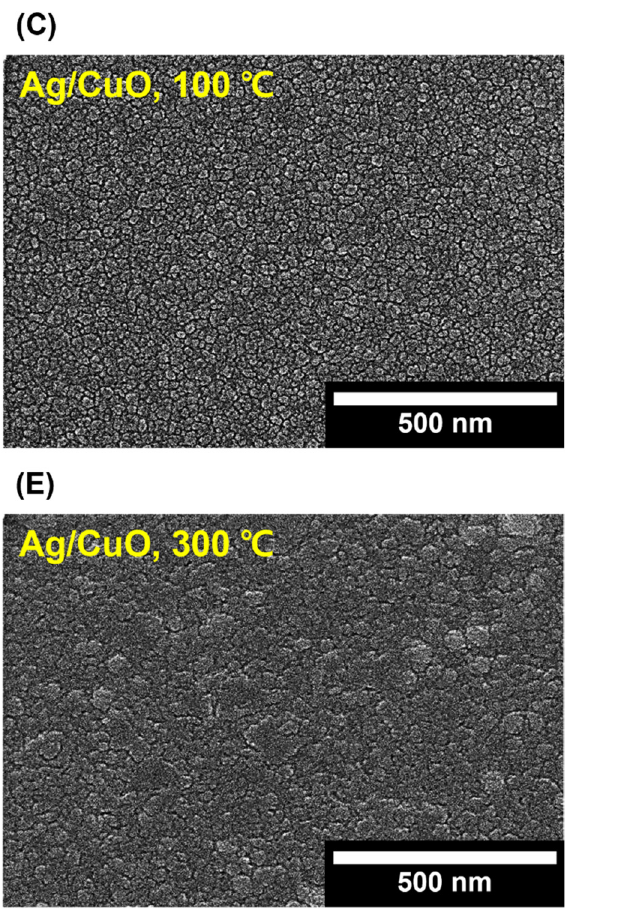
Figure 4. SEM images of surface morphology of Ag/CuO layer deposited on glass substrate: ( A ) cross-section image of Ag/CuO layer; plan-view images of ( B ) as-fabricated Ag/CuO layer at room temperature and postannealed at ( C ) 100 °C; ( D ) 200 °C; ( E ) 300 °C; ( F ) 400 °C.